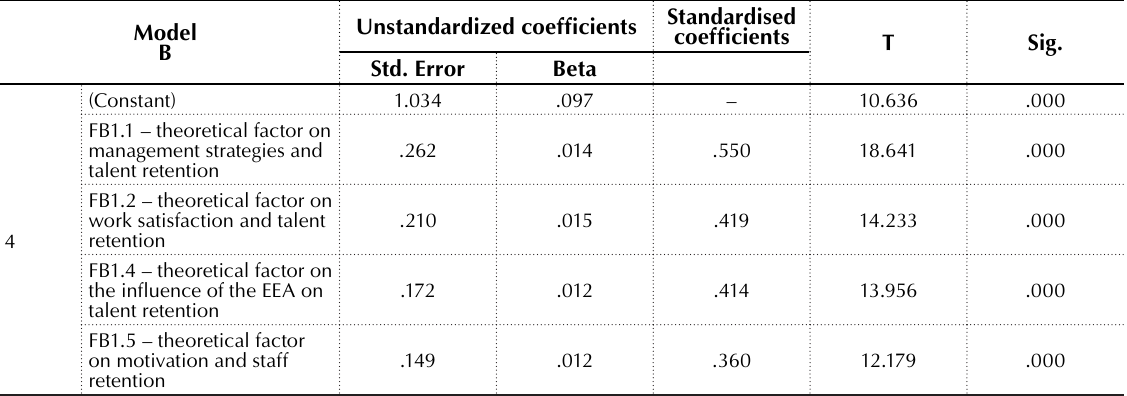
Table 1. The coefficients of the regression